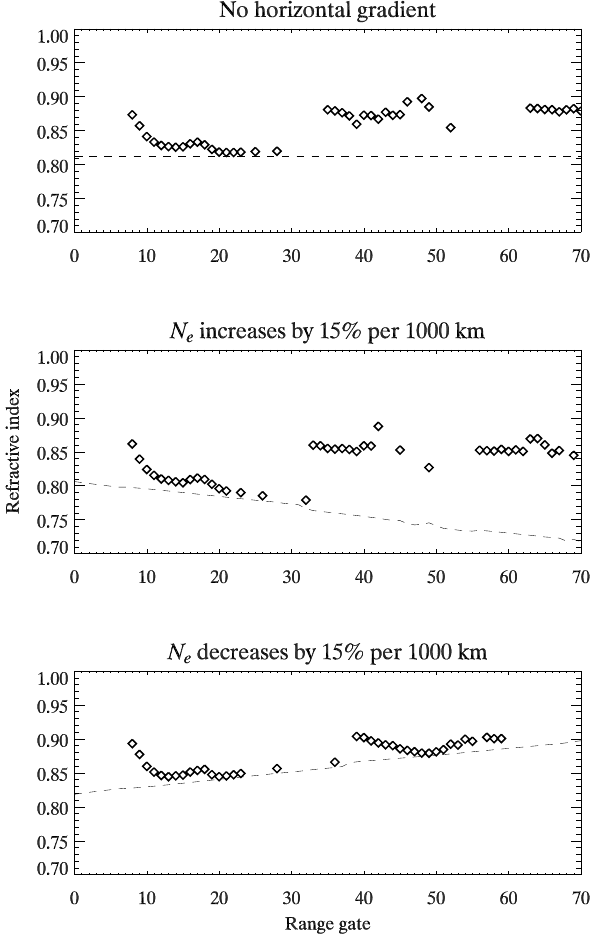
Fig. 9. Effective refractive index for the model data shown in Fig. 6 is shown in the top panel. The remaining panels show the same parameter calculated in the presence of positive (middle panel) and negative (bottom panel) horizontal gradients in the overall electron content. The dashed lines show effective values of the refractive index at the maximum of the F layer for a given range gate.